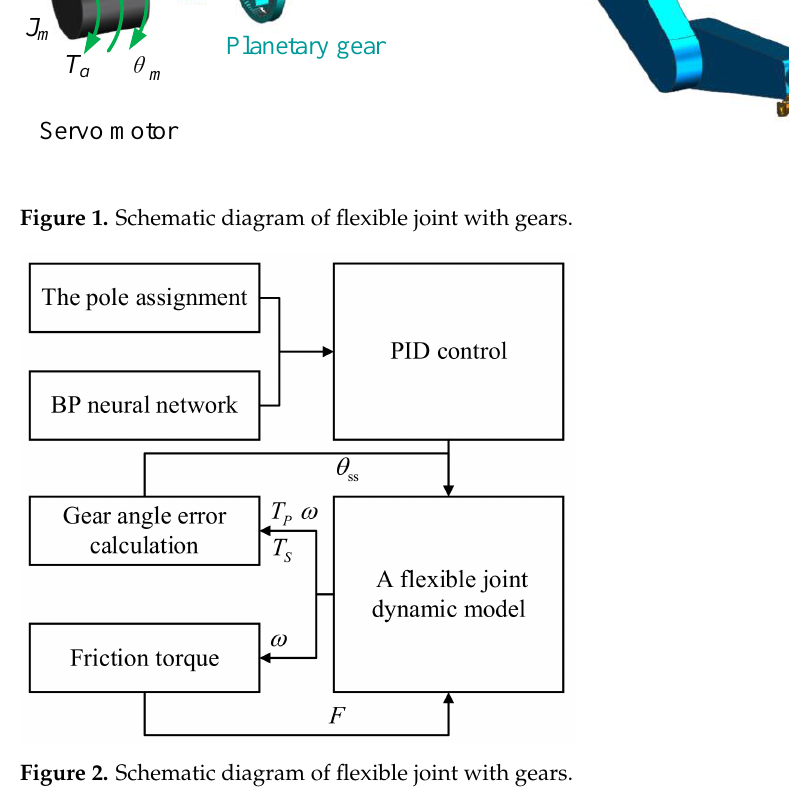
 represents the motor end angle, K represents the J repre-